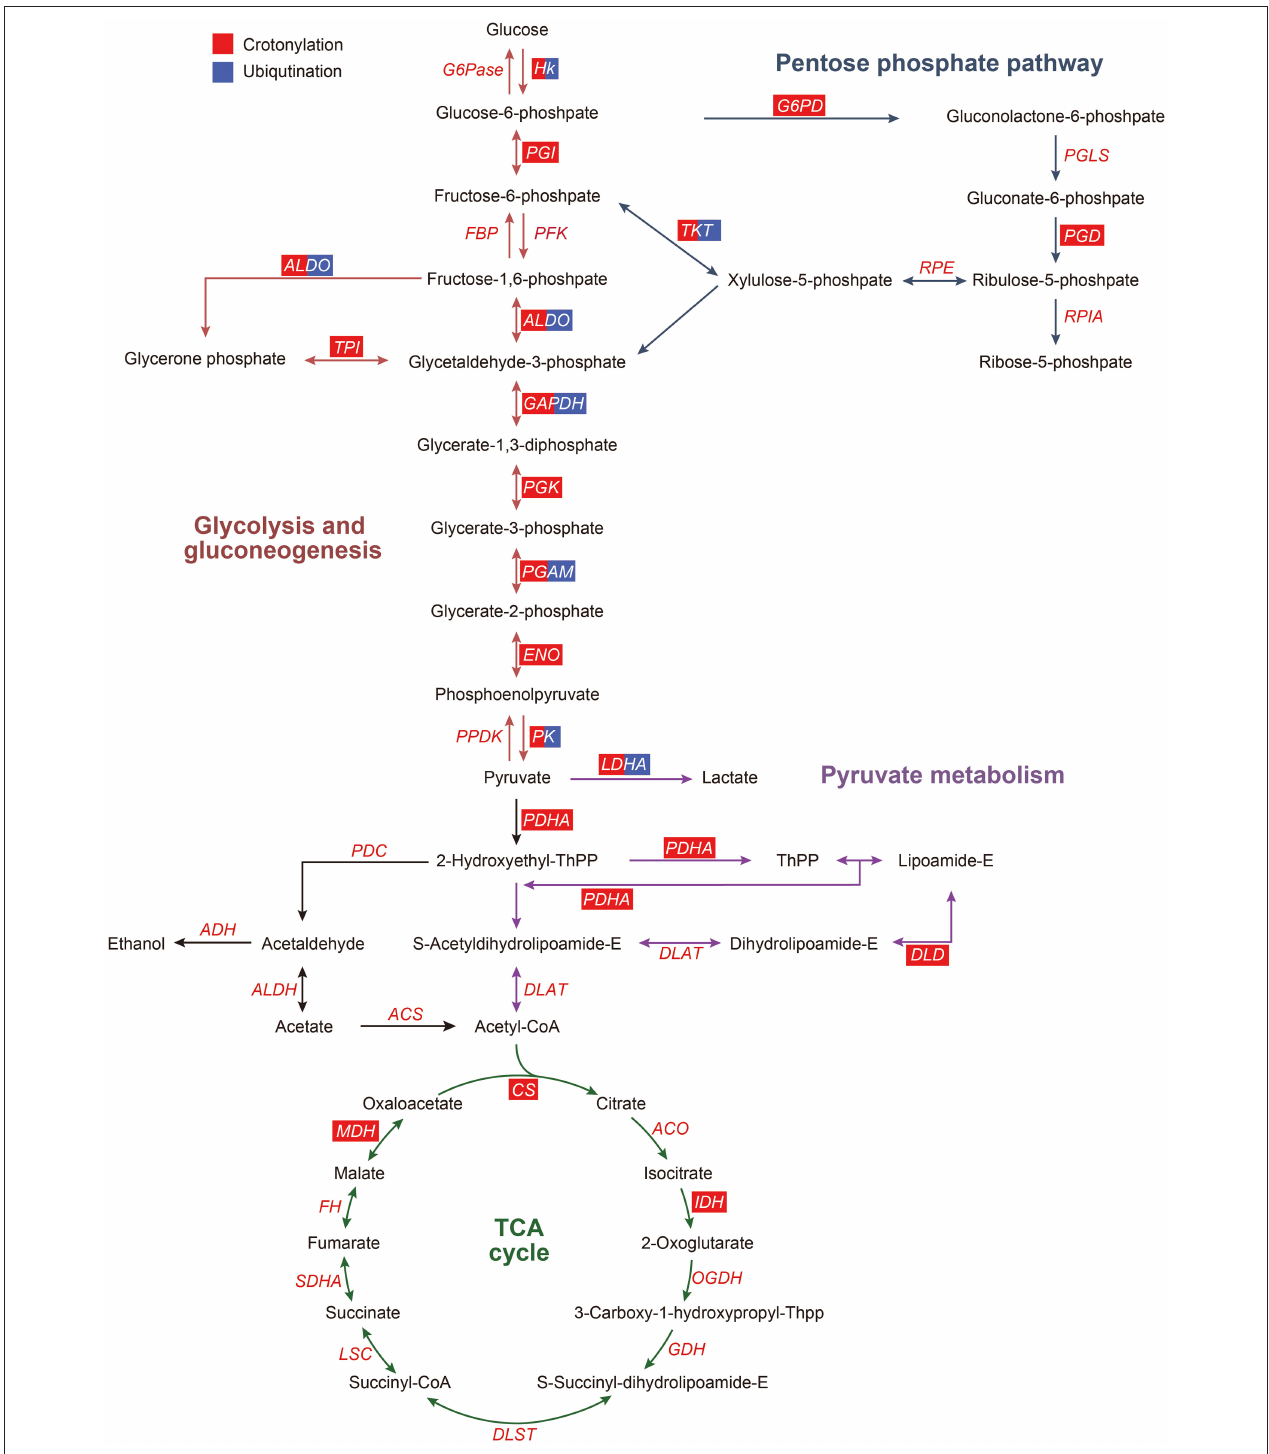
FIGURE 7 | Crotonylated and ubiquitinated enzymes in glycolysis/gluconeogenesis, pentose phosphate pathway, pyruvate metabolism, and TCA cycle. ACO, aconitate hydratase; ACS, acetyl coenzyme A synthetase; ADH, alcohol dehydrogenase; ALDH, aldehyde dehydrogenase; ALDO, aldolase; CS, citrate synthase; DLAT, dihydrolipoamide acetyltransferase (pyruvate dehydrogenase E2 component); DLD, dihydrolipoamide dehydrogenase; DLST, dihydrolipoamide succinyltransferase (2-oxoglutarate dehydrogenase E2 component); ENO, enolase; FBP, fructose-biphosphatase; HK, hexokinase; IDH, isocitrate dehydrogenase; G6Pase, glucose-6-phosphatase; G6PD, glucose-6-phosphate dehydrogenase; GAPDH, glyceraldehyde phosphate dehydrogenase; LDHA, lactate dehydrogenase